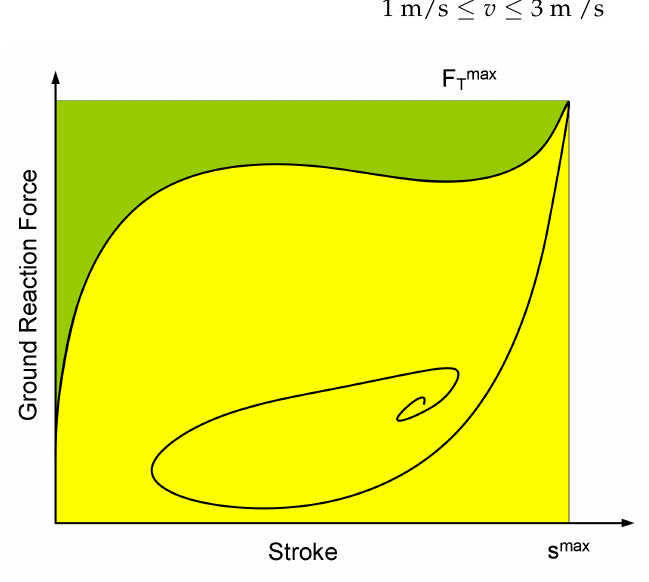
Figure 5. Efficiency curve of a typical landing